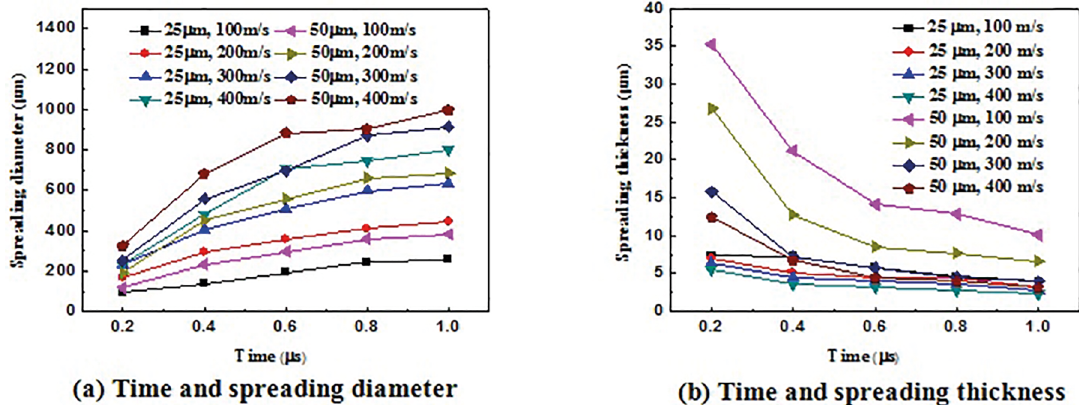
Figure 9. Relationships between droplet spreading diameter and solidification time for (a), and between spreading thickness and solidification time for